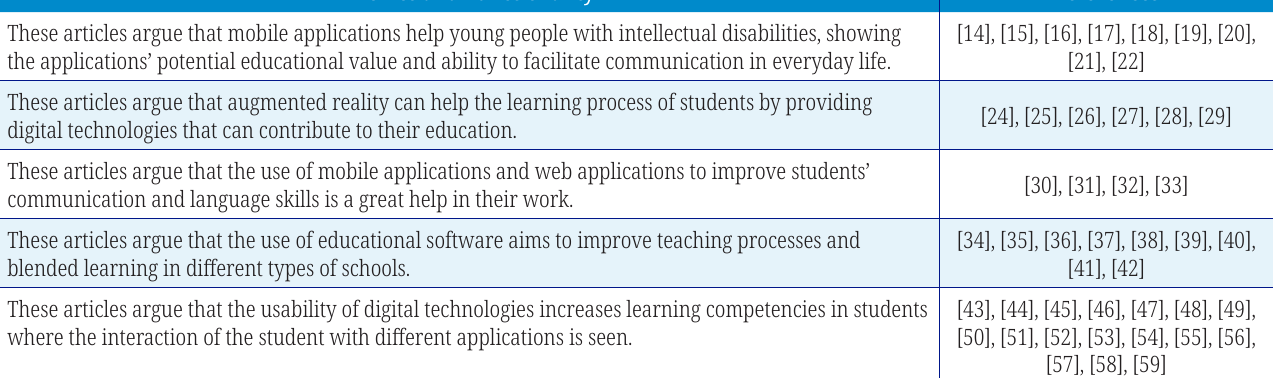
Table 3. Functionality according to classification theme Themes and Functionality